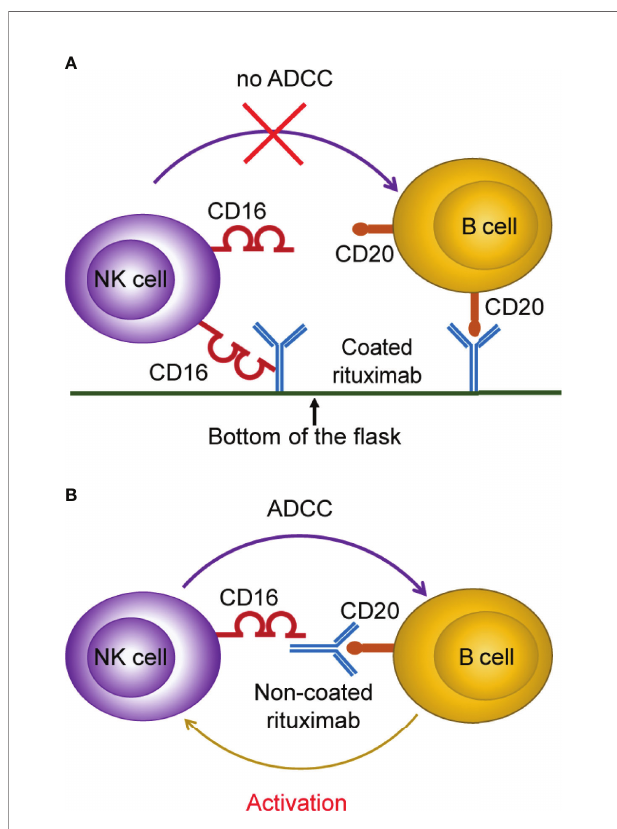
FIGURE 9 | Proposed mechanism of NK cell activation and expansion by non-coated rituximab via B cells. (A) When rituximab is coated at the bottom of the fl ask, the Fc fragment of rituximab binds to the bottom surface of the fl ask, making it dif fi cult to bind NK cells and B cells at the same time, and inhibiting the ADCC effect to activate NK cells. (B) When rituximab was not coated at the bottom of the fl ask, it could bind NK cells and B cells simultaneously and activate NK cells through the ADCC